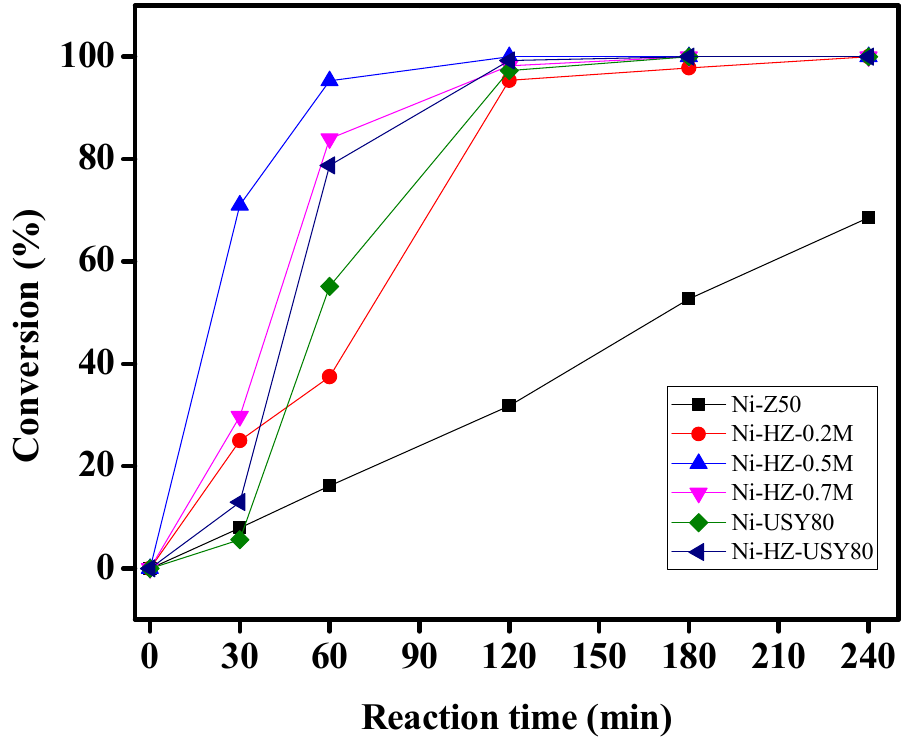
Figure 9. Catalytic performances of bifunctional Ni-supported hierarchical zeolite catalysts in citral hydrogenation reaction with reaction time.